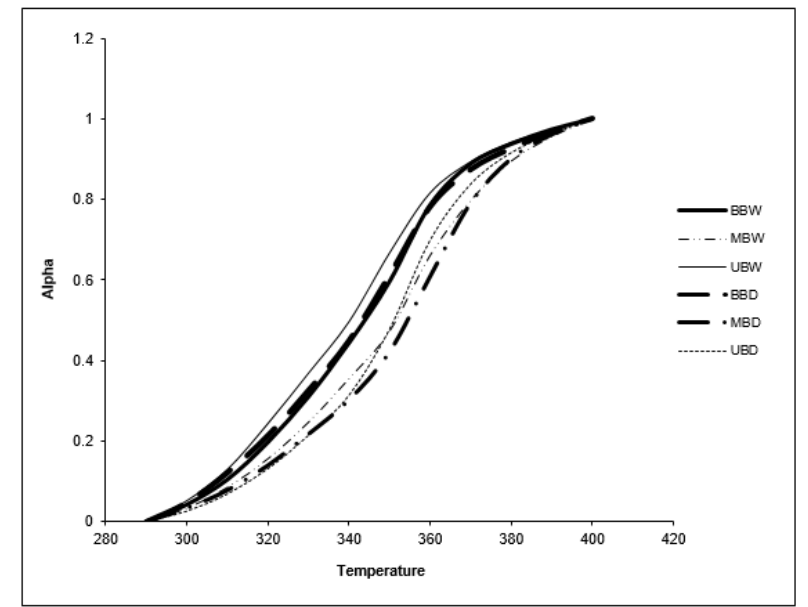
Figure 9. Alpha vs. temperature relationship for okra bast fibers.